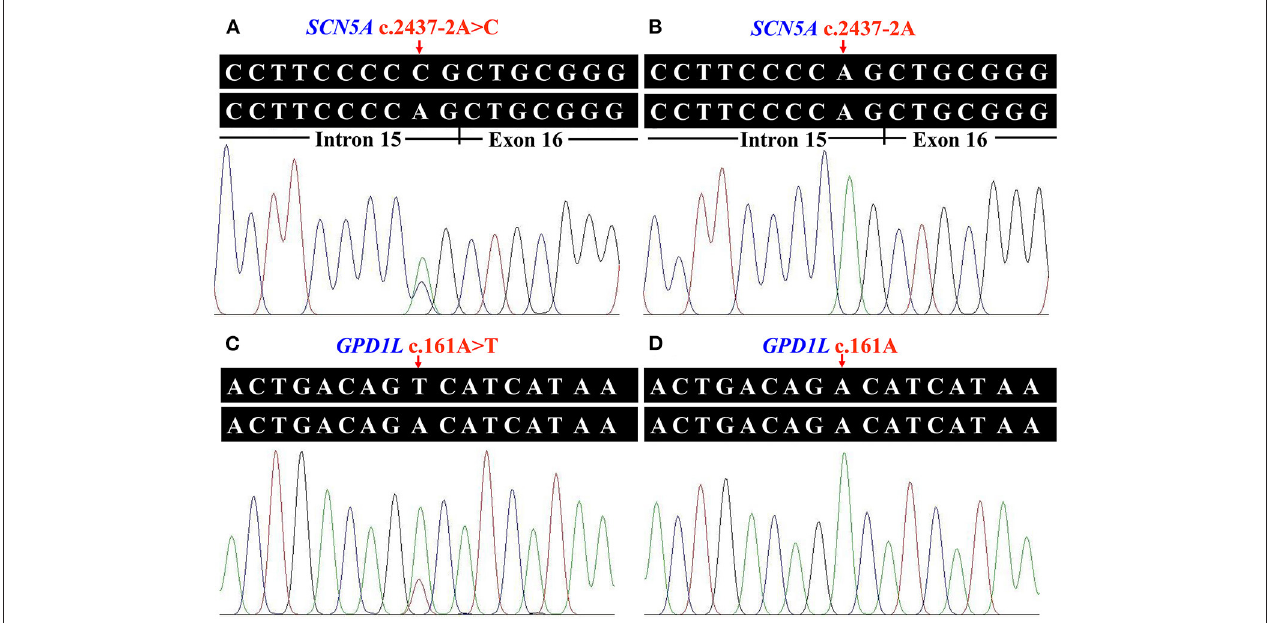
FIGURE 2 | Identified variants of the sodium voltage-gated channel alpha subunit 5 gene ( SCN5A ) and the glycerol-3-phosphate dehydrogenase 1 like gene ( GPD1L ) in the two patients. (A) Heterozygous transversion (c.2437-2A > C) at the splice acceptor site of SCN5A intron 15 in Patient 1. (B) The normal SCN5A sequence of an unaffected individual. (C) The GPD1L sequence with heterozygous c.161A > T [p.(Asp54Val)] variant in Patient 2. (D) The normal GPD1L sequence of an unaffected individual.